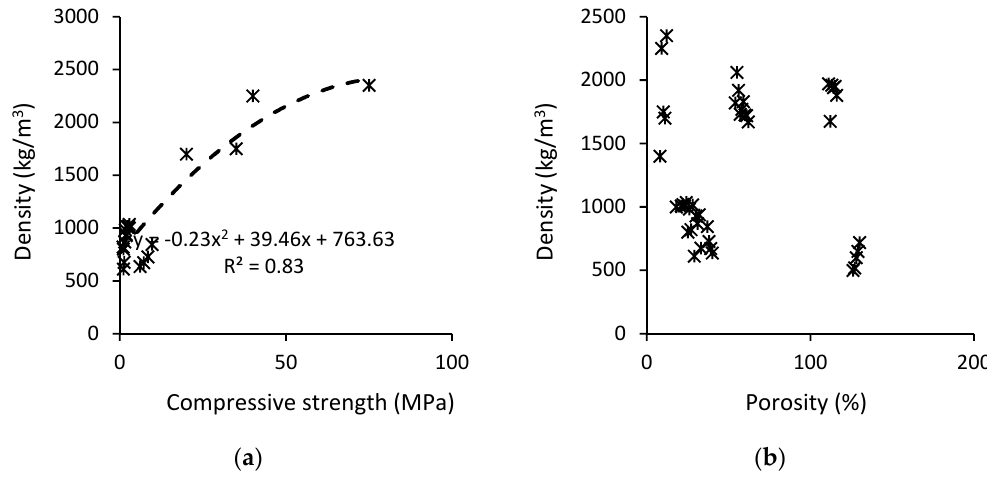
Figure 10. Relationship between density and ( a ) compressive strength and ( b ) porosity of AAM.